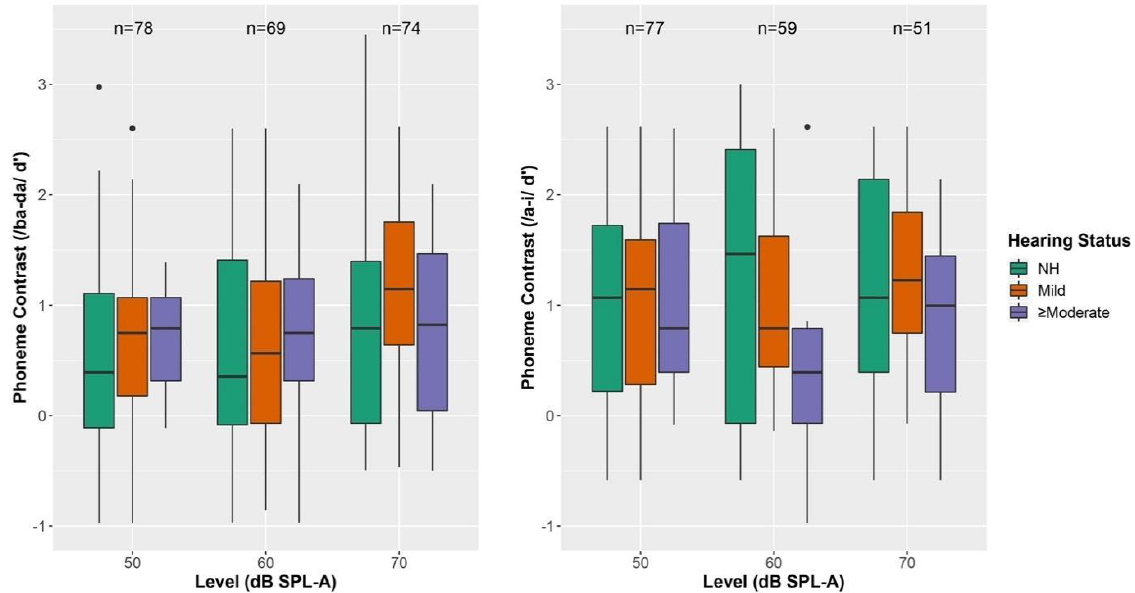
Figure 2. Performance on CHT as a function of presentation level. Note: Normal hearing (NH); Sound Pressure Level A-Weighted (SPL-A) Speech discrimination is shown in d’ for listeners who completed both tasks. The left panel represents performance for the /ba-da/ contrast (y-axis) and the right panel represents performance for the /a-i/ contrast (y-axis). Box plot represents the minimum, first quartile, median, third quartile and maximum. Dots represent participants 2.70 SDs or more from the mean.